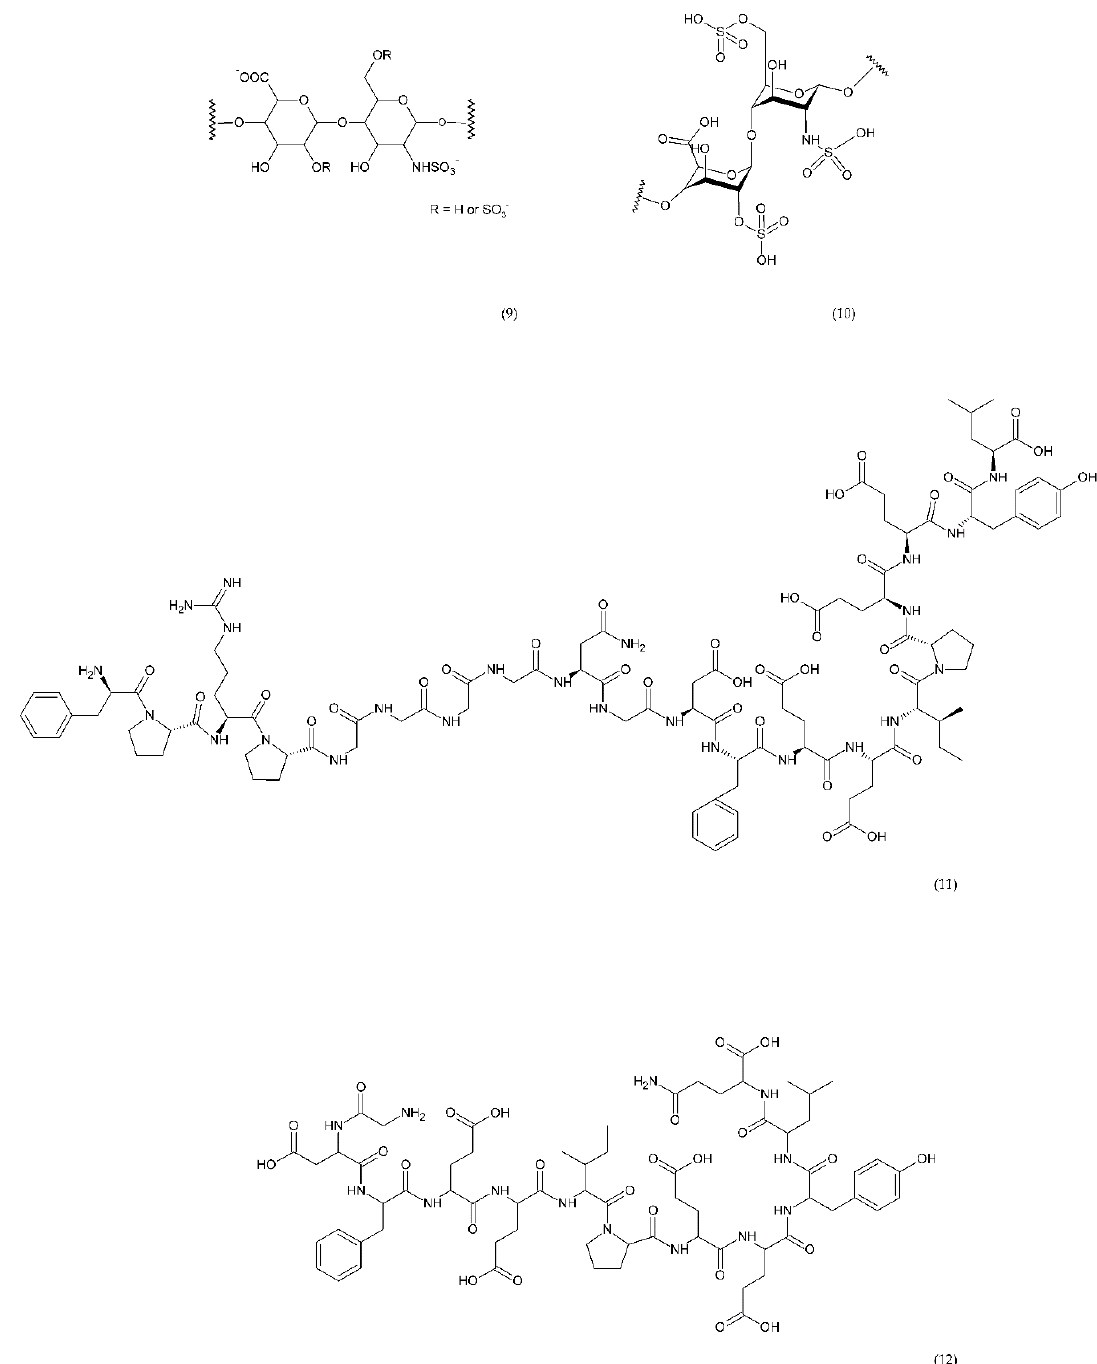
Figure 7. Direct bivalent thrombin inhibitors: low molecular weight heparin (LMWH) monomer structure (9), heparin (10), bivalirudin (11), and hirudin (12).